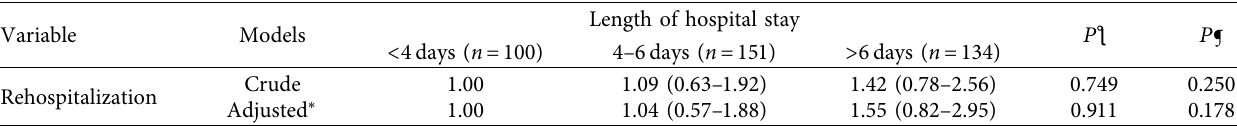
Table 3: Crude and adjusted odds ratio of rehospitalization according to the length of hospital